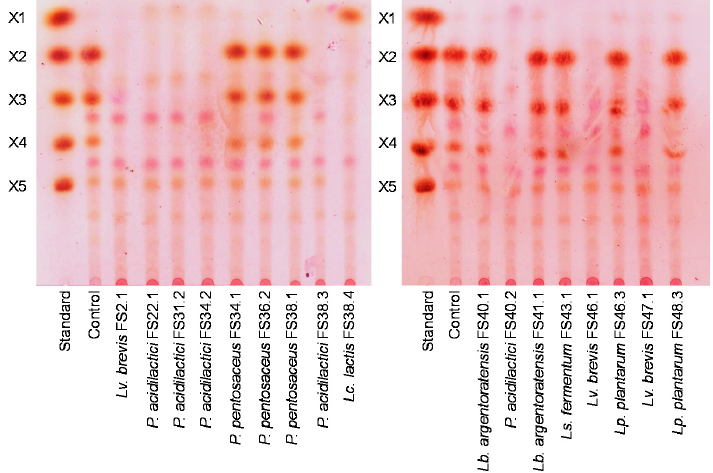
Figure 5. TLC chromatogram of the XOSs fermentation broth of the selected XOSs-fermenting LAB after XOSs fermentation at 37 °C for 24 h. X1 = xylose; X2 = xylobiose; X3 = xylotriose; X4 = xylotetraose; X5 = xylopentaose.